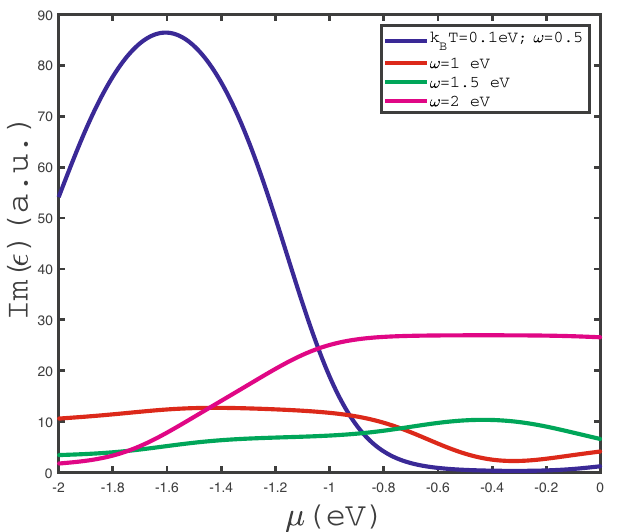
Figure 10. Optical absorption, Im (ǫ) , of doped MoS 2 layer as a function of chemical potential µ at fixed 0.1 eV for different values of frequency ω in the absence of strain. temperature k B T =